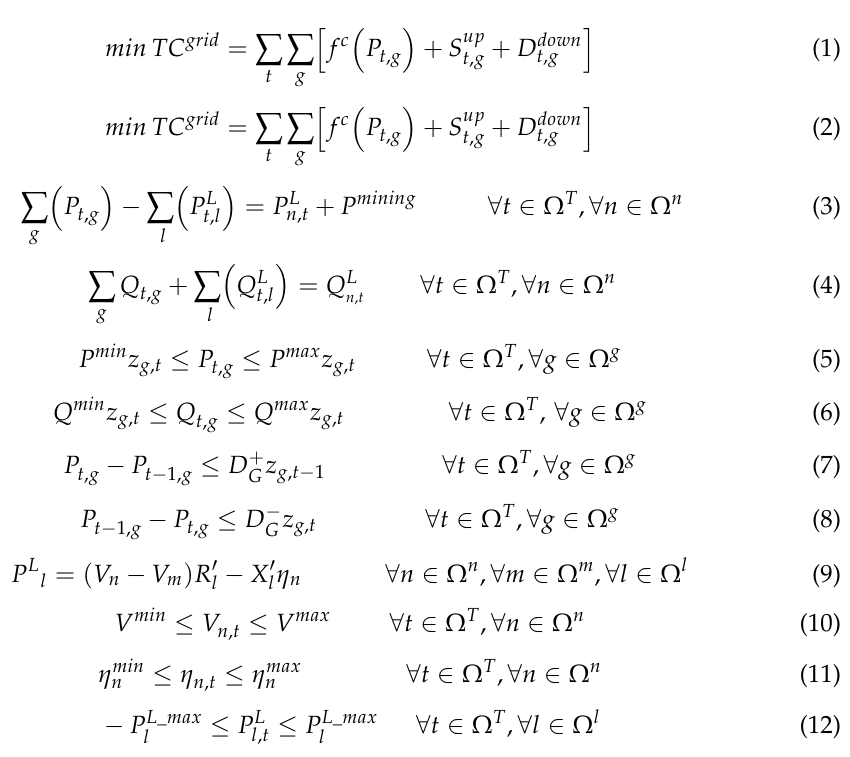
Figure 1. Illustration of the electrical grid based on the mining devices.